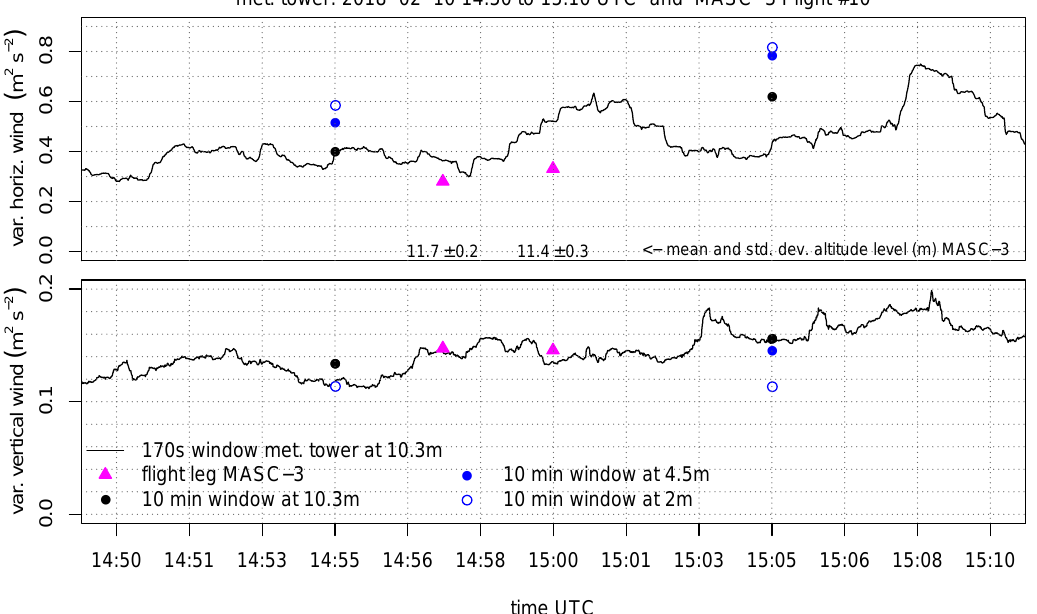
Figure 11. Time series of the tower with the corresponding leg averages of MASC-3 at the lowest flight levels for the variance of the horizontal wind Var v ( top ) and the vertical wind component h Var w ( bottom ). The mean altitude and standard deviation of the individual flight leg is given for the MASC-3 data points. The data of the tower at 10.3 m is calculated on a moving window with a width of ∆ t tower = 170 s corresponding to the fetch of the MASC-3 flight legs with an average duration of ∆ t UAS = 80 s. Furthermore the neighboring ten minute averages of the tower at all height levels are given. The Var w for the first ten minute interval of the tower at 10.3 m and 4.5 m lie on top of each